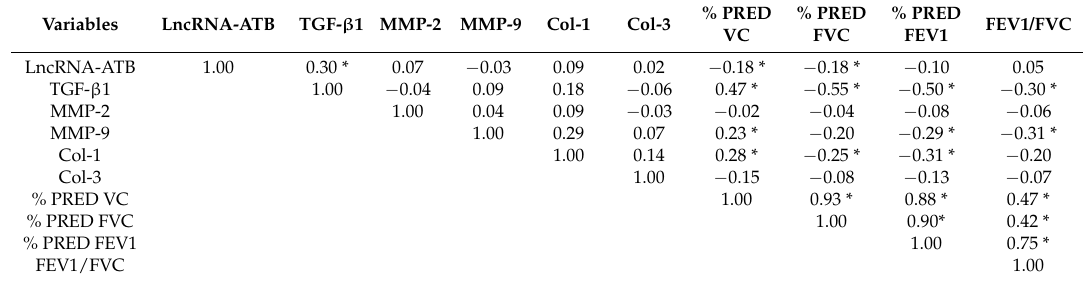
Table 3. Correlations between lncRNA-ATB and clinical-/biological features in CWP patients † .